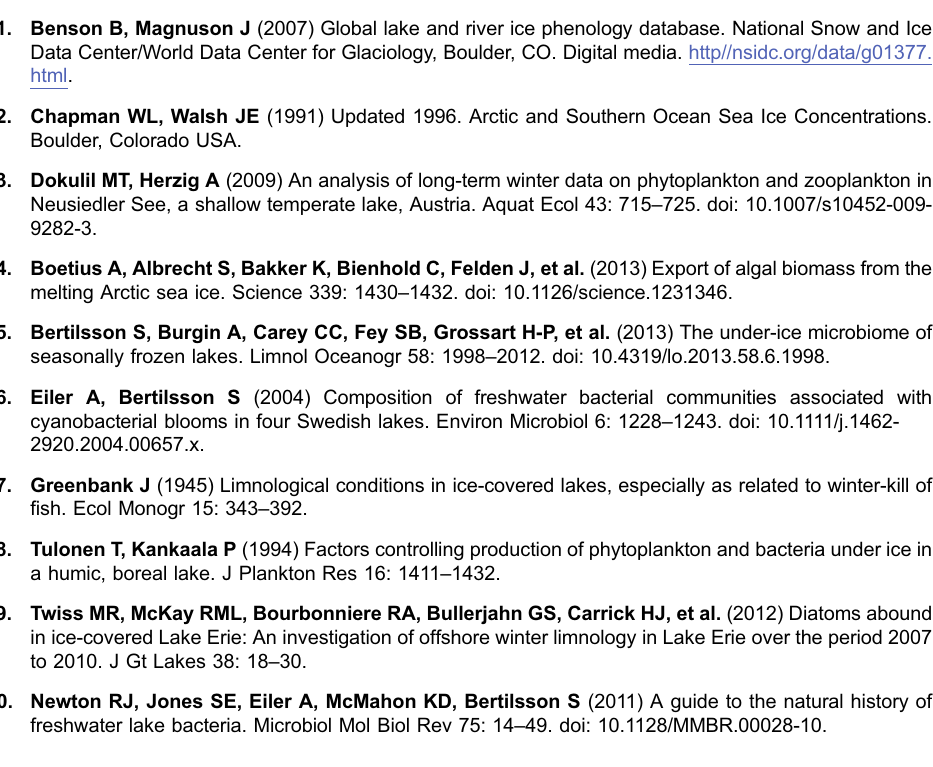
Table S2. Oligonucleotide probes used in this study. Table S3. Sequence quality and diversity data for each sample. Table S4. List of bacterial tax paths. Table S5. Under-ice phytoplankton blooms in limnic and marine